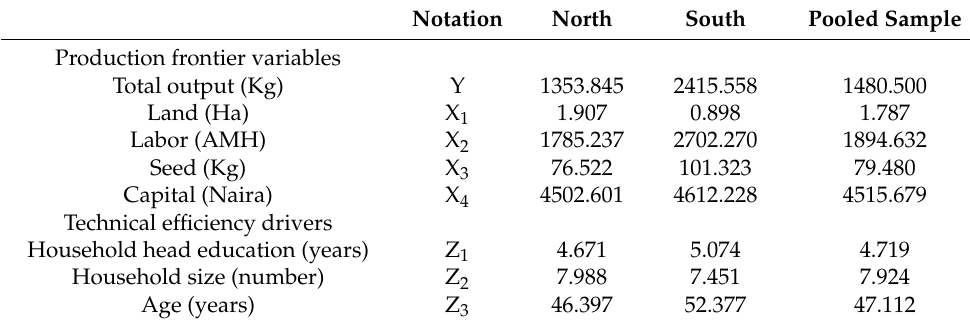
Table 2. Descriptive statistics of farm characteristics,